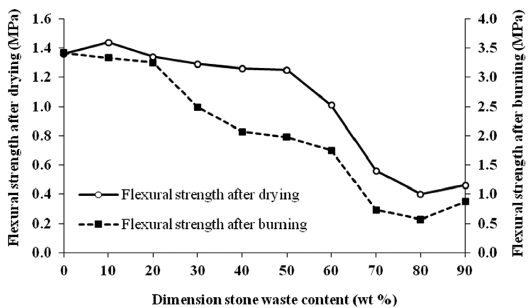
Figure 8. Flexural strength after drying (MPa) and flexural strength after burning (MPa) as a function of dimension stone waste content